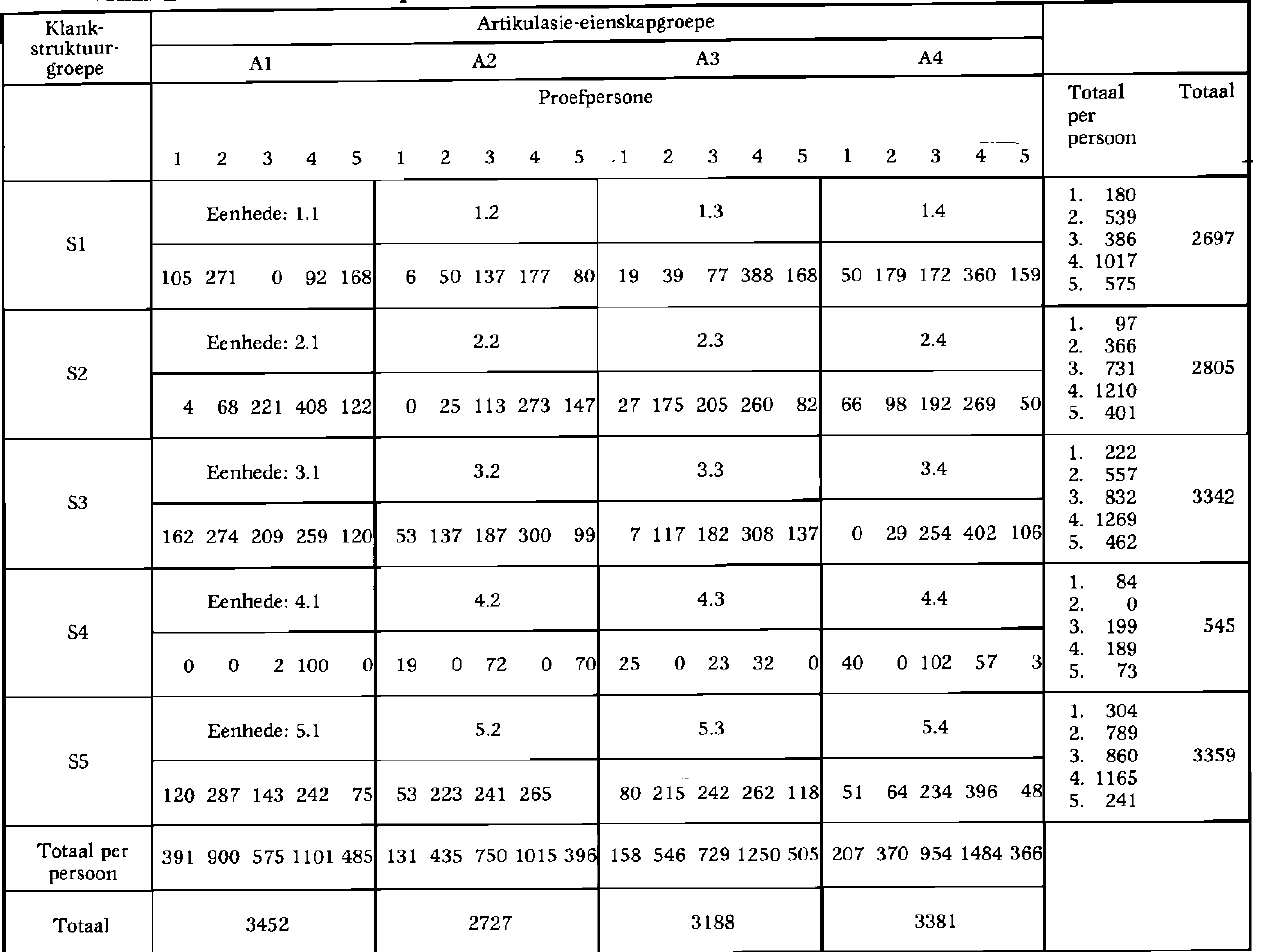
Tabel 4: Die verskil in millisekondes tussen die gemiddelde vokaalduur van die proefpersoon en die gemiddelde vokaalduur van die